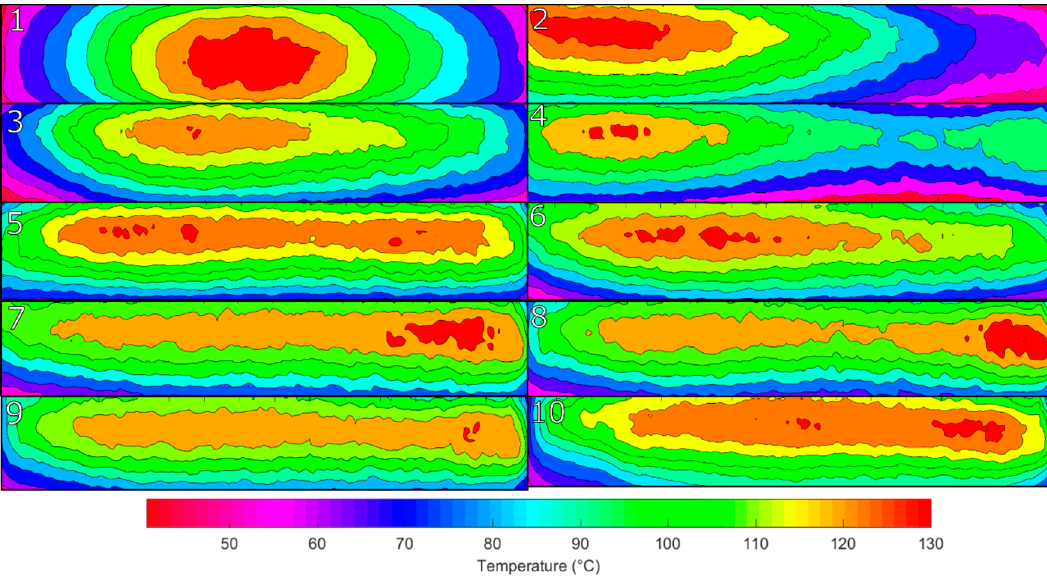
Figure 19. The third repetition of the Greyscale–Threshold hybrid (GT) method is shown in the contour plots of the surface temperature profile measurements shown after each cycle of ablation.